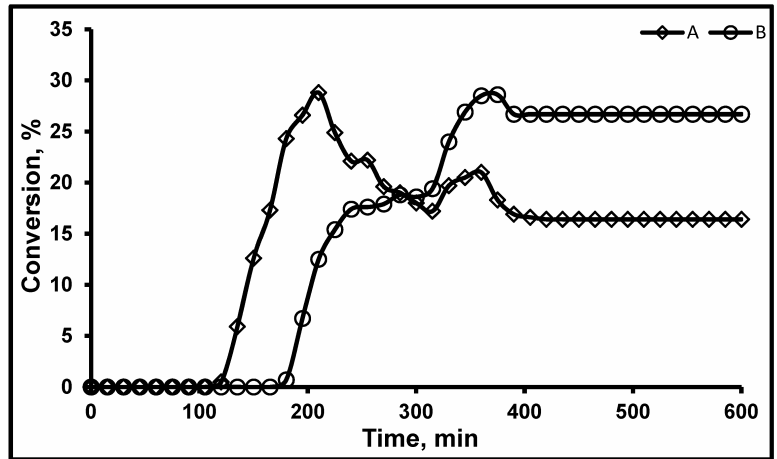
Figure 6. Conversion of EO in the presence of NaBH 4 using (A) Ag/SiO 2 and (B) Ag/Co 3 O 4 as the